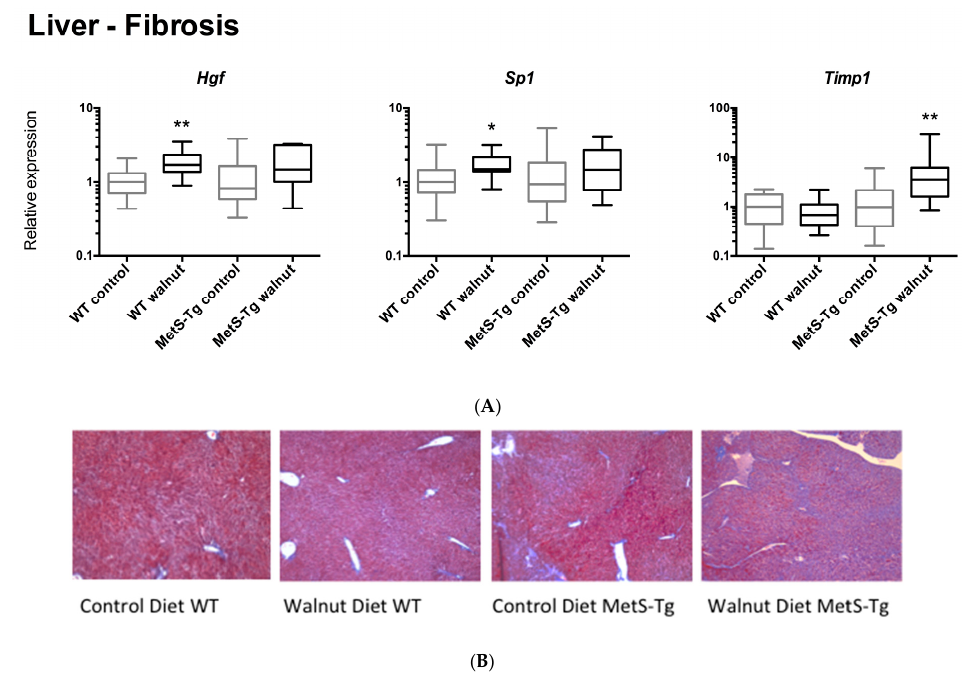
Figure 2. ( A ): Relative levels of gene expression in liver for genes associated with fibrosis ( Hgf , Sp1 , Timp1 ), as medians (Interquartile Ranges) with WT control expression set to 1, * p < 0.05, ** p < 0.005. ( B ): Representative sections of liver tissue stained with Masson Trichrome, indicating a gradient of interstitial fibrosis (blue), lowest in WT Control diet, and highest in MetS-Tg Walnut diet (10× magnification).